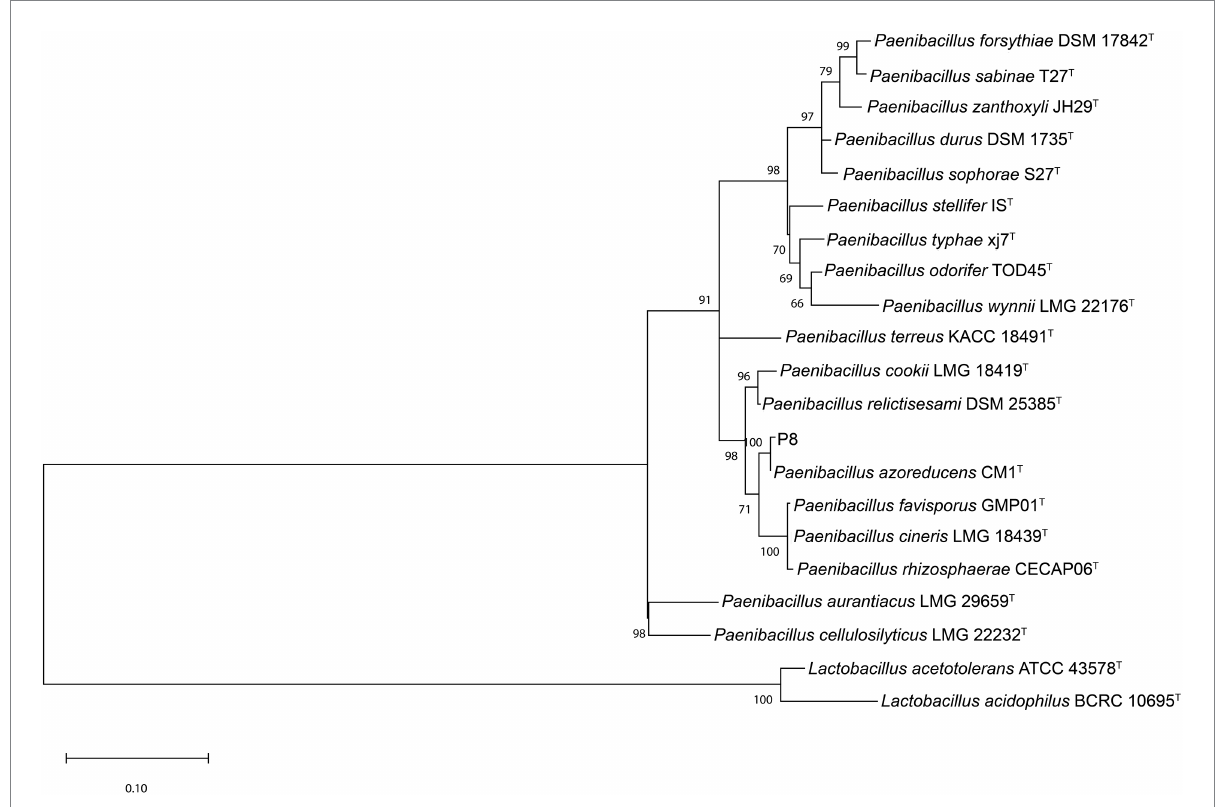
FIGURE 2 Phylogenetic tree of based on the 16S rRNA gene sequence of strain P8 and representative strains from